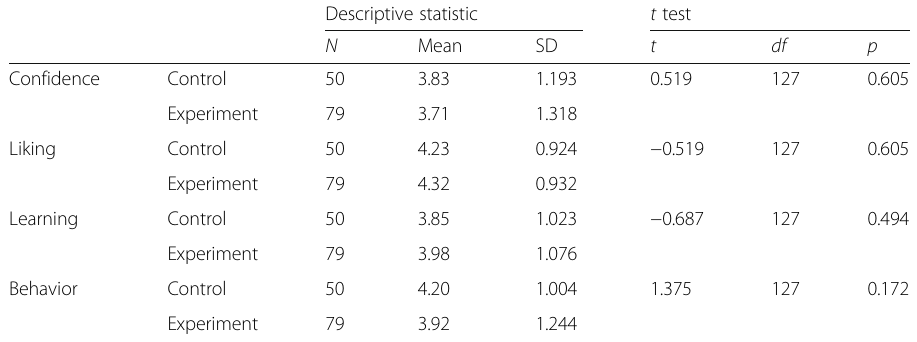
Table 6 Independent t test result for students ’ CGAS score in control and experiment groups Descriptive statistic